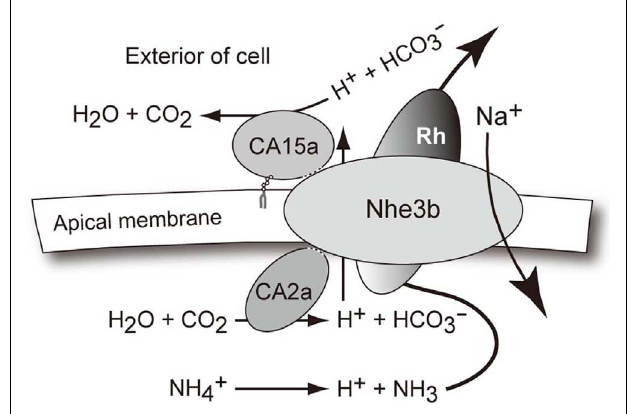
FIGUREA4 |A hypothetical model for the interaction of CA2a, CA15a, Nhe3b, and Rhcg1 acting together as a transport metabolon or transportsome to take up Na + in freshwater. Concerning the Na + uptake by zebrafish in FW conditions, it seems plausible that at the apical side of H-MRC, Na + is taken up by sodium/proton exchanger Nhe3b in exchange for H + , which is generated by carbonic anhydrase CA2a.The excreted H + is then titrated by CA15a. Although not shown in the transport metabolon model, H + may also be secreted via H + -ATPase.The net reaction results in accumulation of Na + and HCO − , as typically seen in the mammalian renal 3 proximal tubule cells for reabsorption of bicarbonate and sodium ions (Shirley and Unwin, 2005; Purkerson and Schwartz, 2007; Bobulescu and Moe, 2009). Concerning the major driving force, however, the two systems must be quite different since the local ionic gradients are much less favorable for Na + /H + exchange in the case of FW fish H-MRCs whose apical membrane is energized by H + -ATPase (Harvey andWieczorek, 1997; Nakhoul and Hamm, 2002). Extra H + generated from NH + may act as a part 4 of driving force for